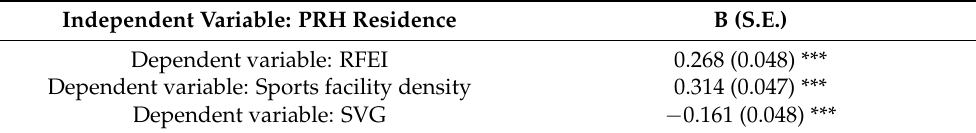
Table 3. Regression model results of RPH residence on food, sports, and greenery